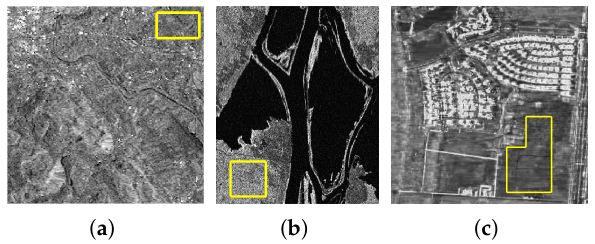
Figure 11. The selected patches of T 1 image of each dataset used for calculating the ENL. ( a – c ) illustrate the selected regions of Bern, Ottawa and Tongzhou despeckled data, respectively. The selected patch of the original Tongzhou image is the same as that of the despeckled